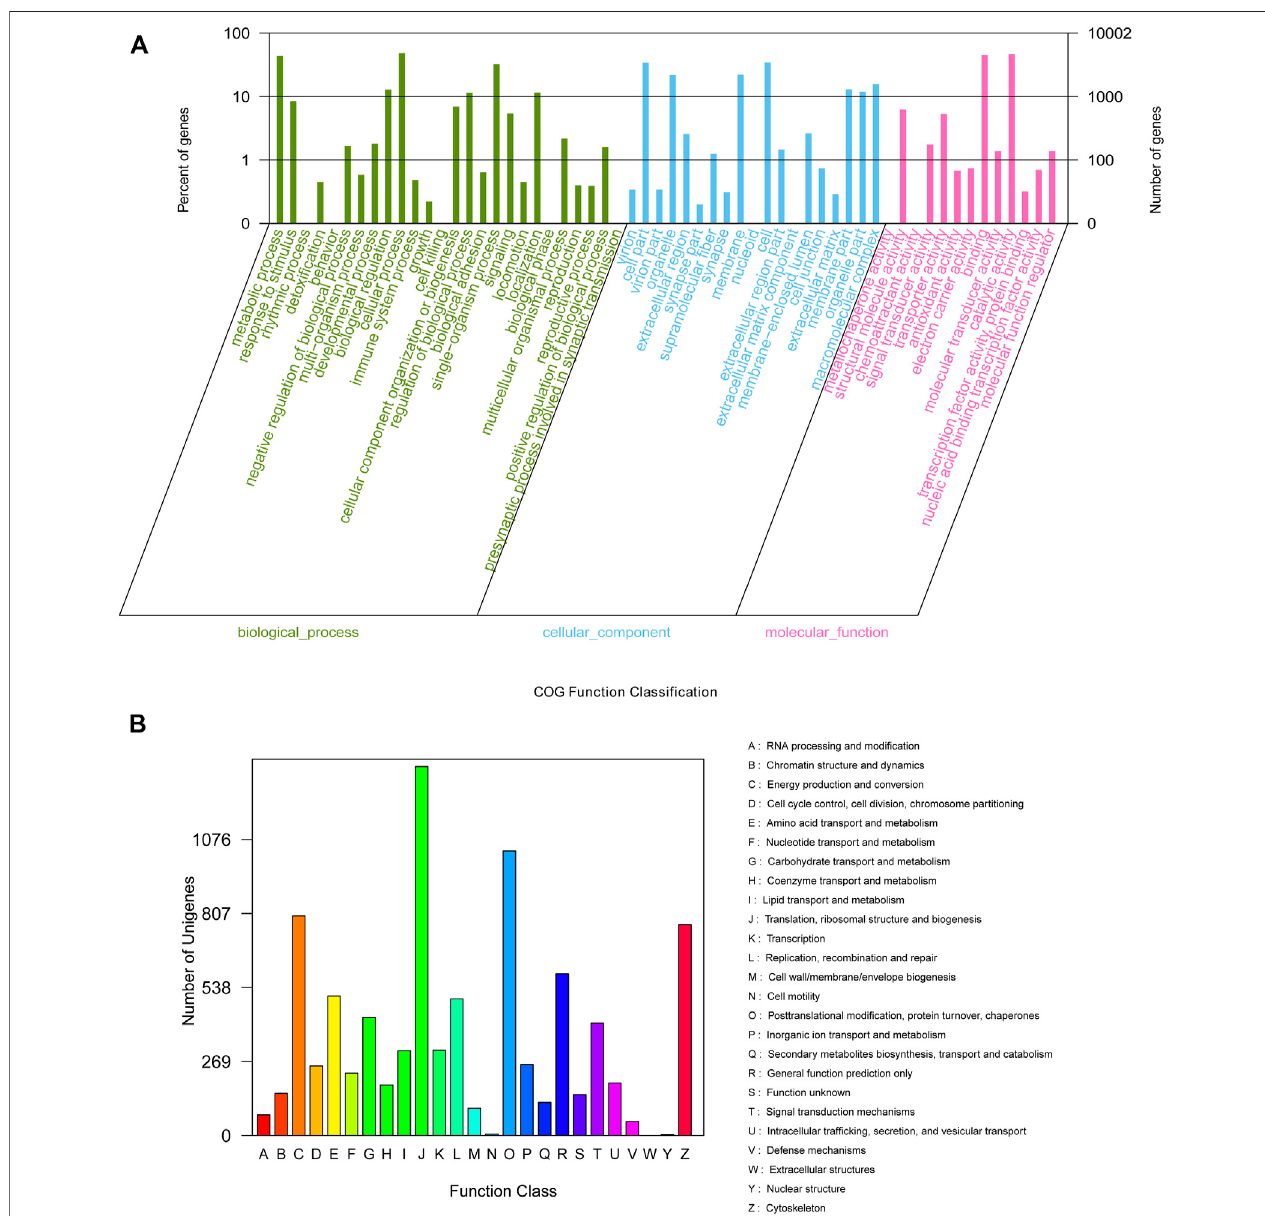
FIGURE 1 | GO (A) categorization and COG (B) functional classi fi cation of assembled unigenes.